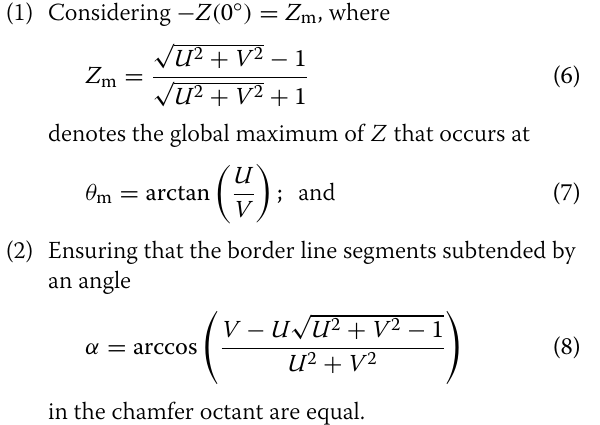
(cid:9) (cid:8) (cid:9) (cid:8) r r , and ,0 , C (cid:6) = , r a b b